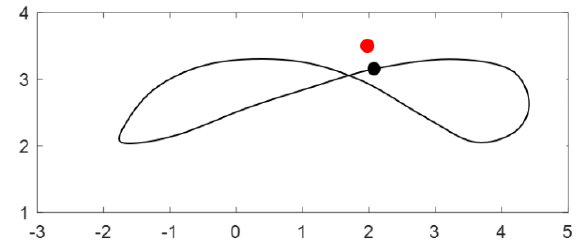
Figure 5. Generated trajectory and prescribed point (red).